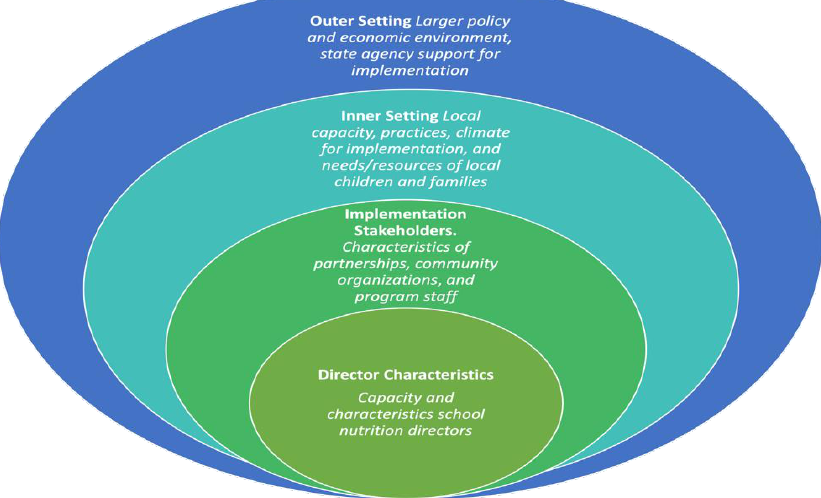
Figure 1. Social Ecological Model (SEM) and Consolidated Framework for Implementation Research (CFIR)-based coding framework of multi-level implementation factors influencing school meal program operations during COVID-19.